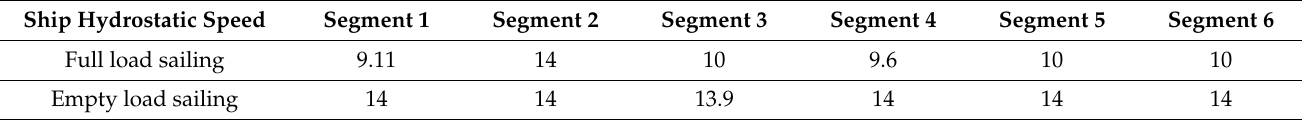
Table 4. Sailing plan of the ship in one whole